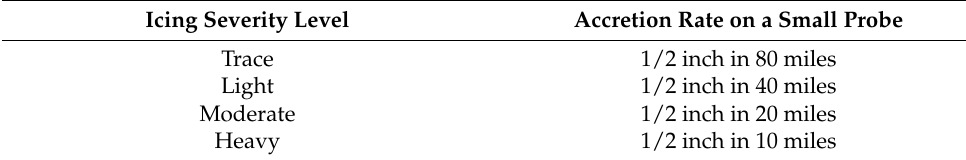
Table 2. Icing severity level based on icing thickness [37] . Table 1. 1964 NCCAM icing standards [35].